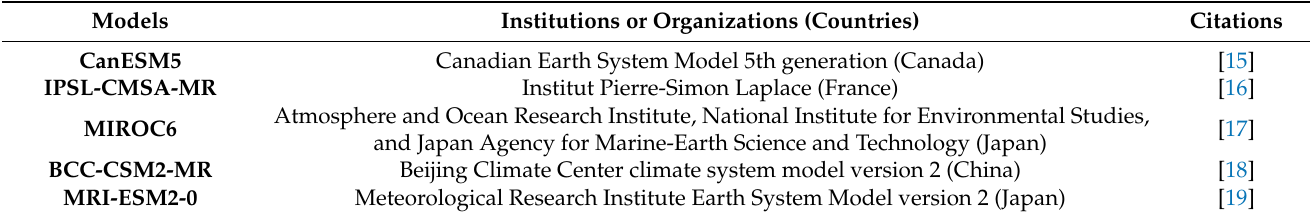
Table 1. CMIP6 models with their respective responsible institutions, countries and quotes. Models